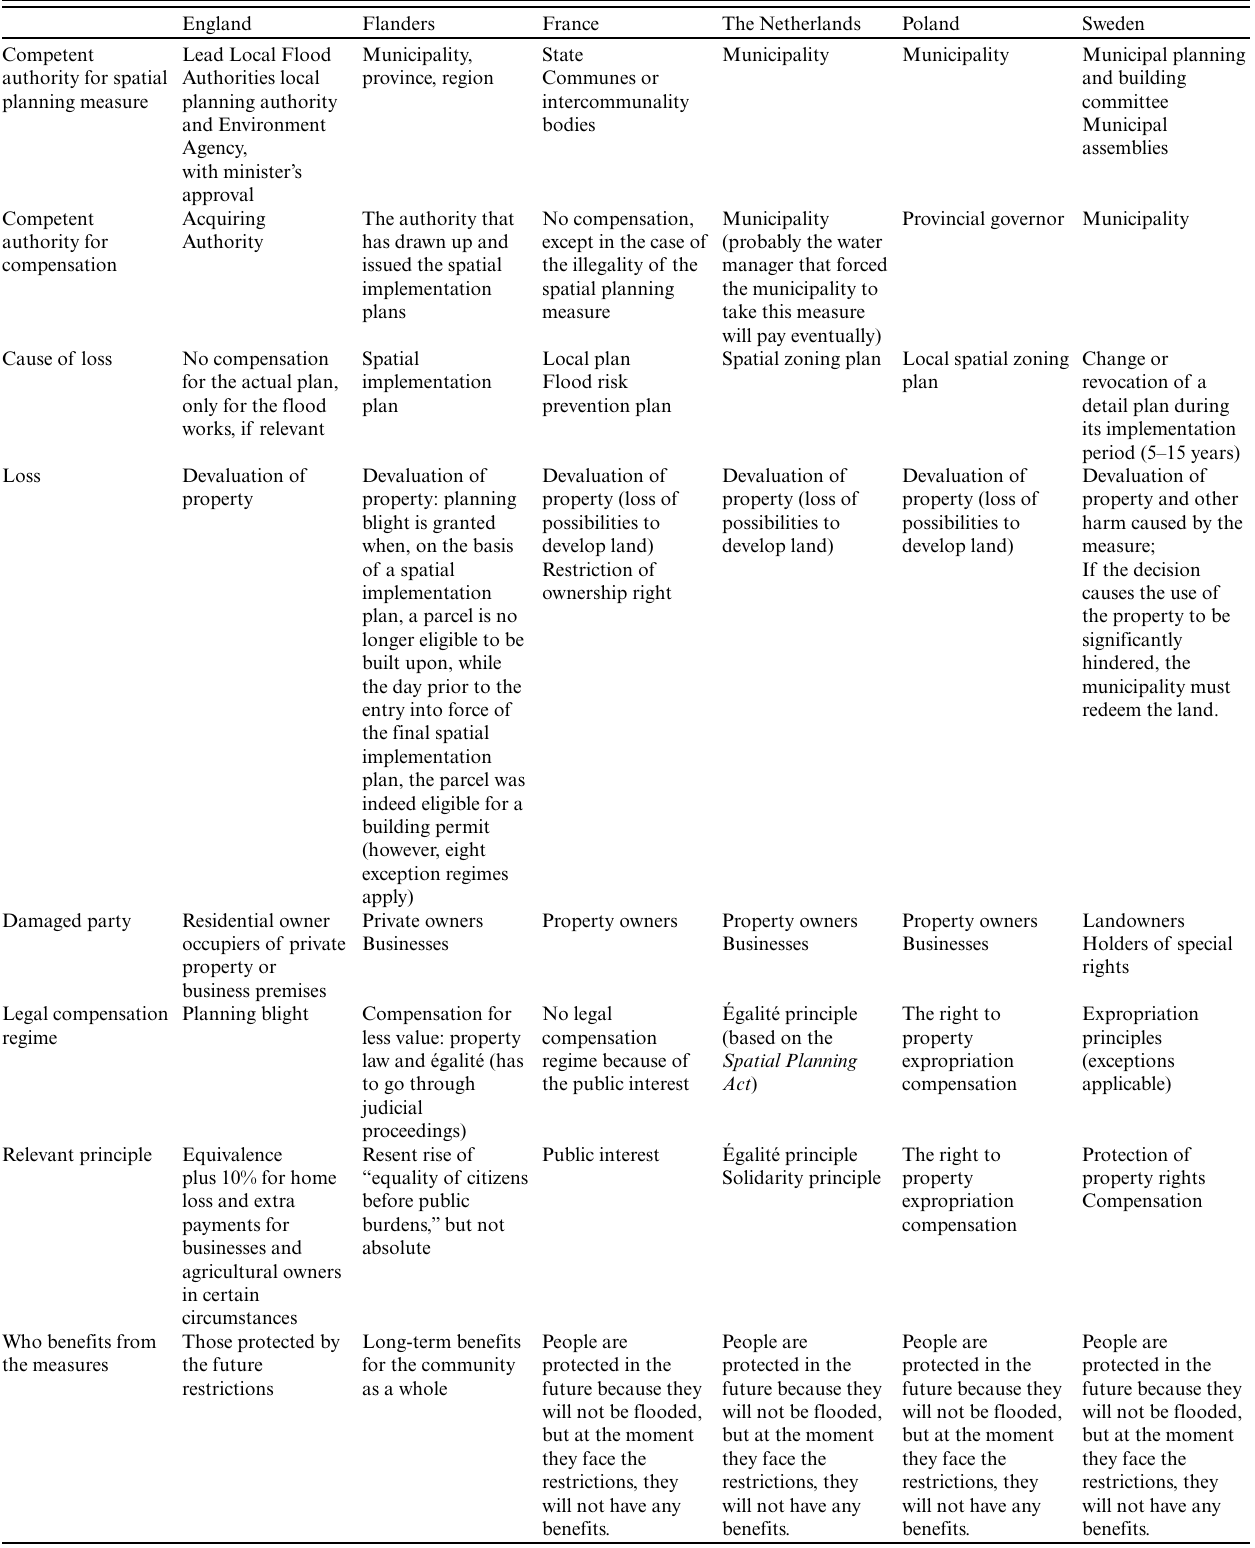
Table 3. . Spatial planning